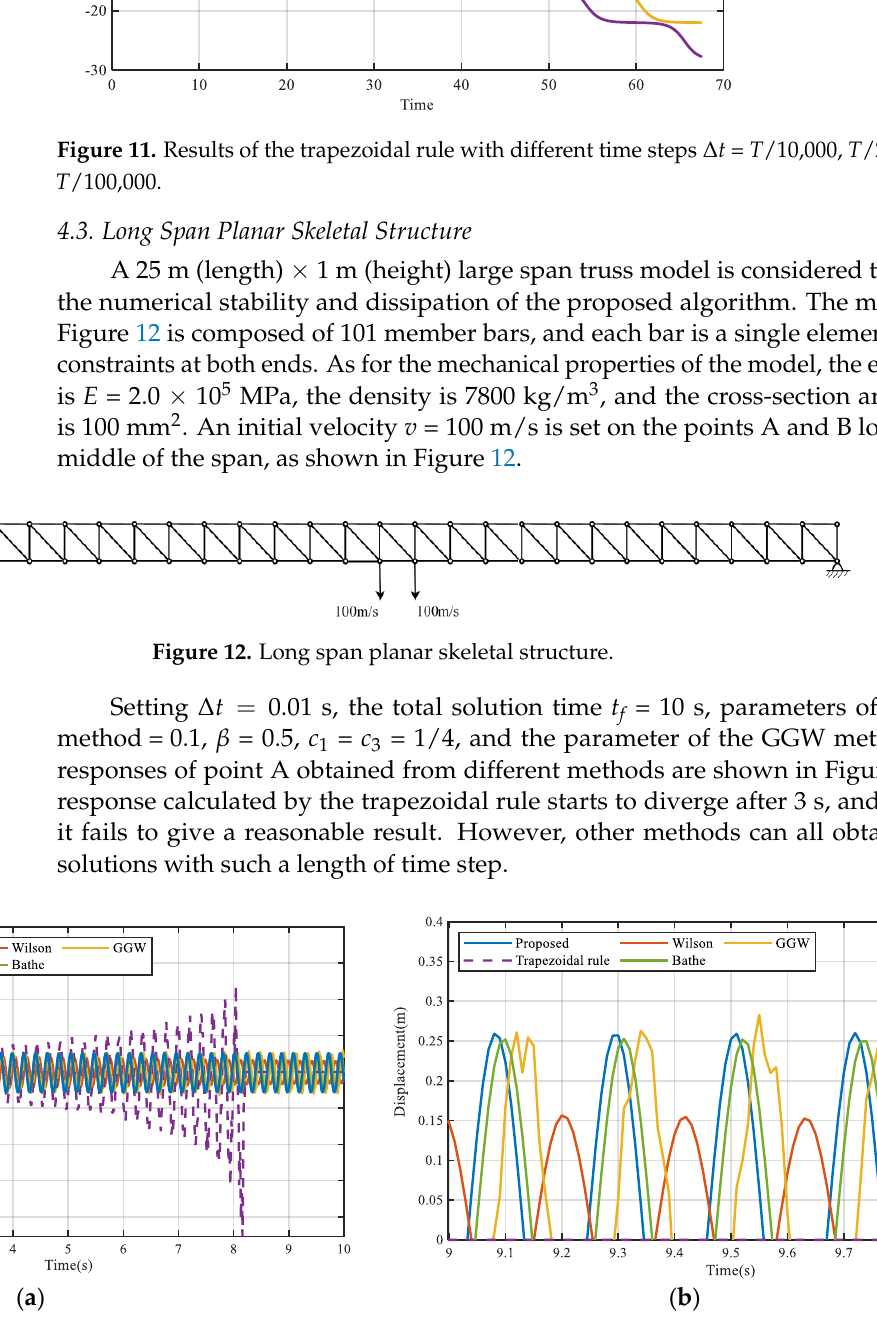
Figure 11. Results of the trapezoidal rule with different time steps Δ t = T /10,000, T /20,000, T /50,000, T /100,000. Table 2. Computational time of different methods for Problem 4.2.